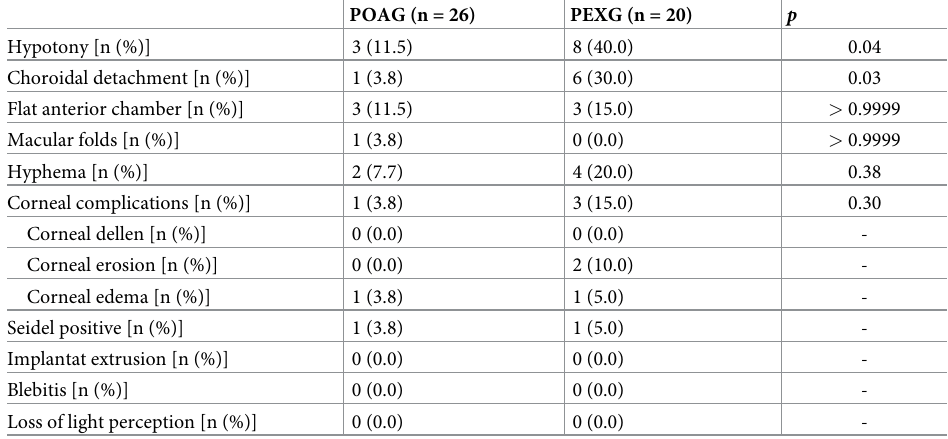
Table 2. Postoperative